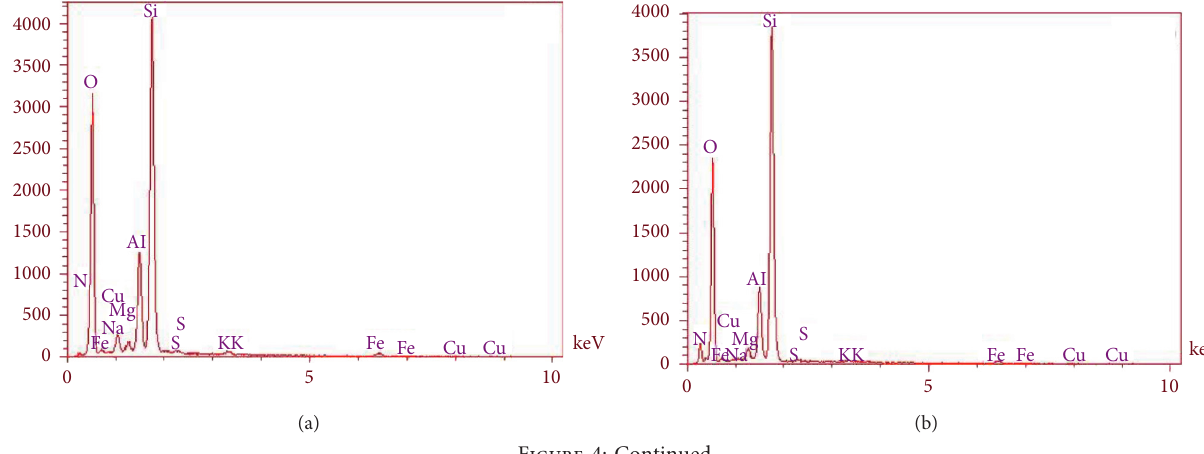
Figure 3: X-ray diffraction (XRD) patterns of MMT K10 (a), MMT-[(CH NH � CHPy]-Cu(II)